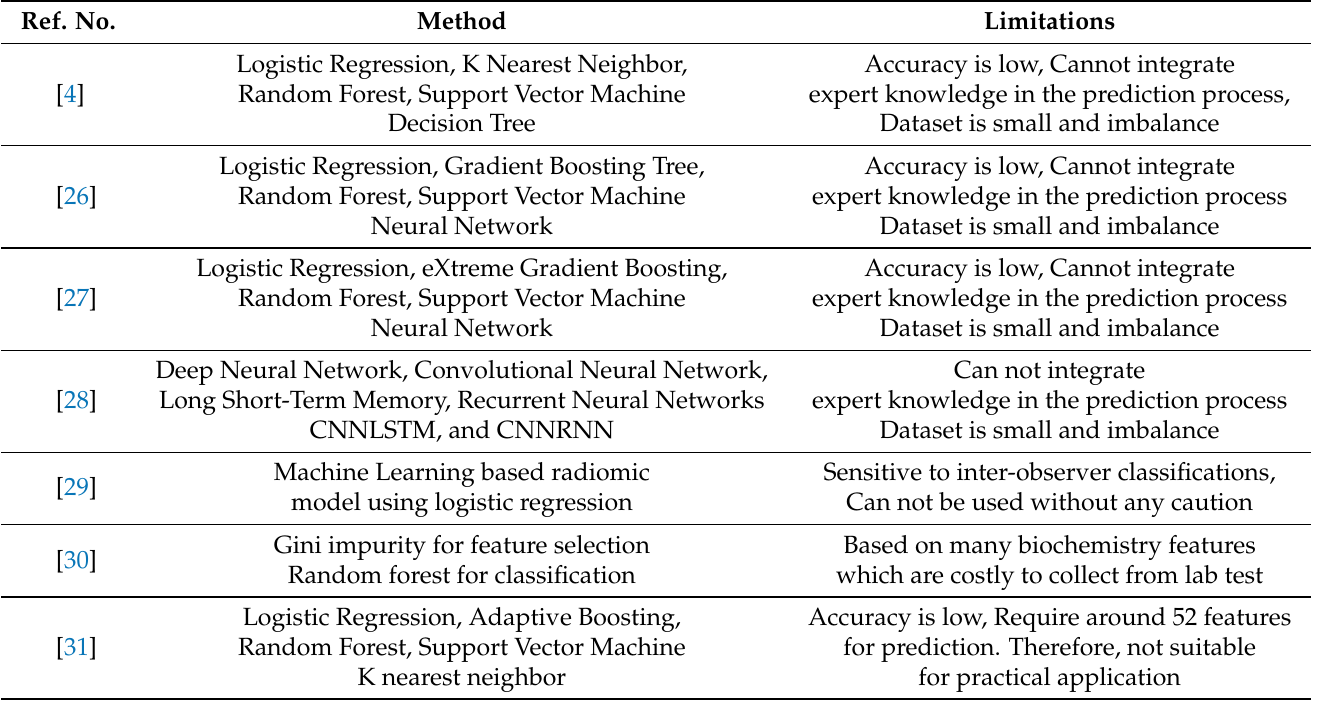
Table 1. Summary of the related